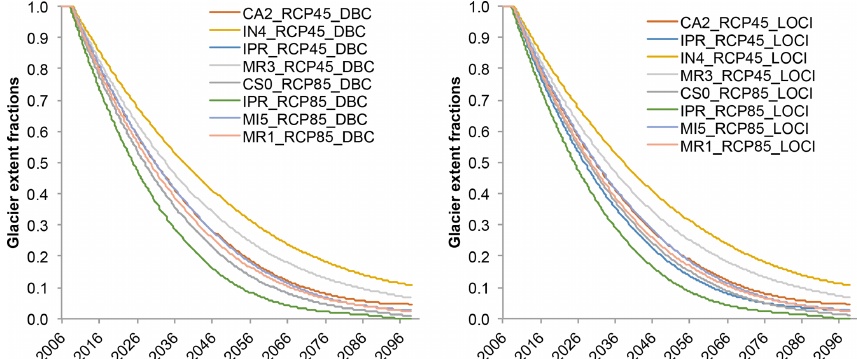
Figure 10. Projected changes in glacier extent for the upper Beas basin during the 21st